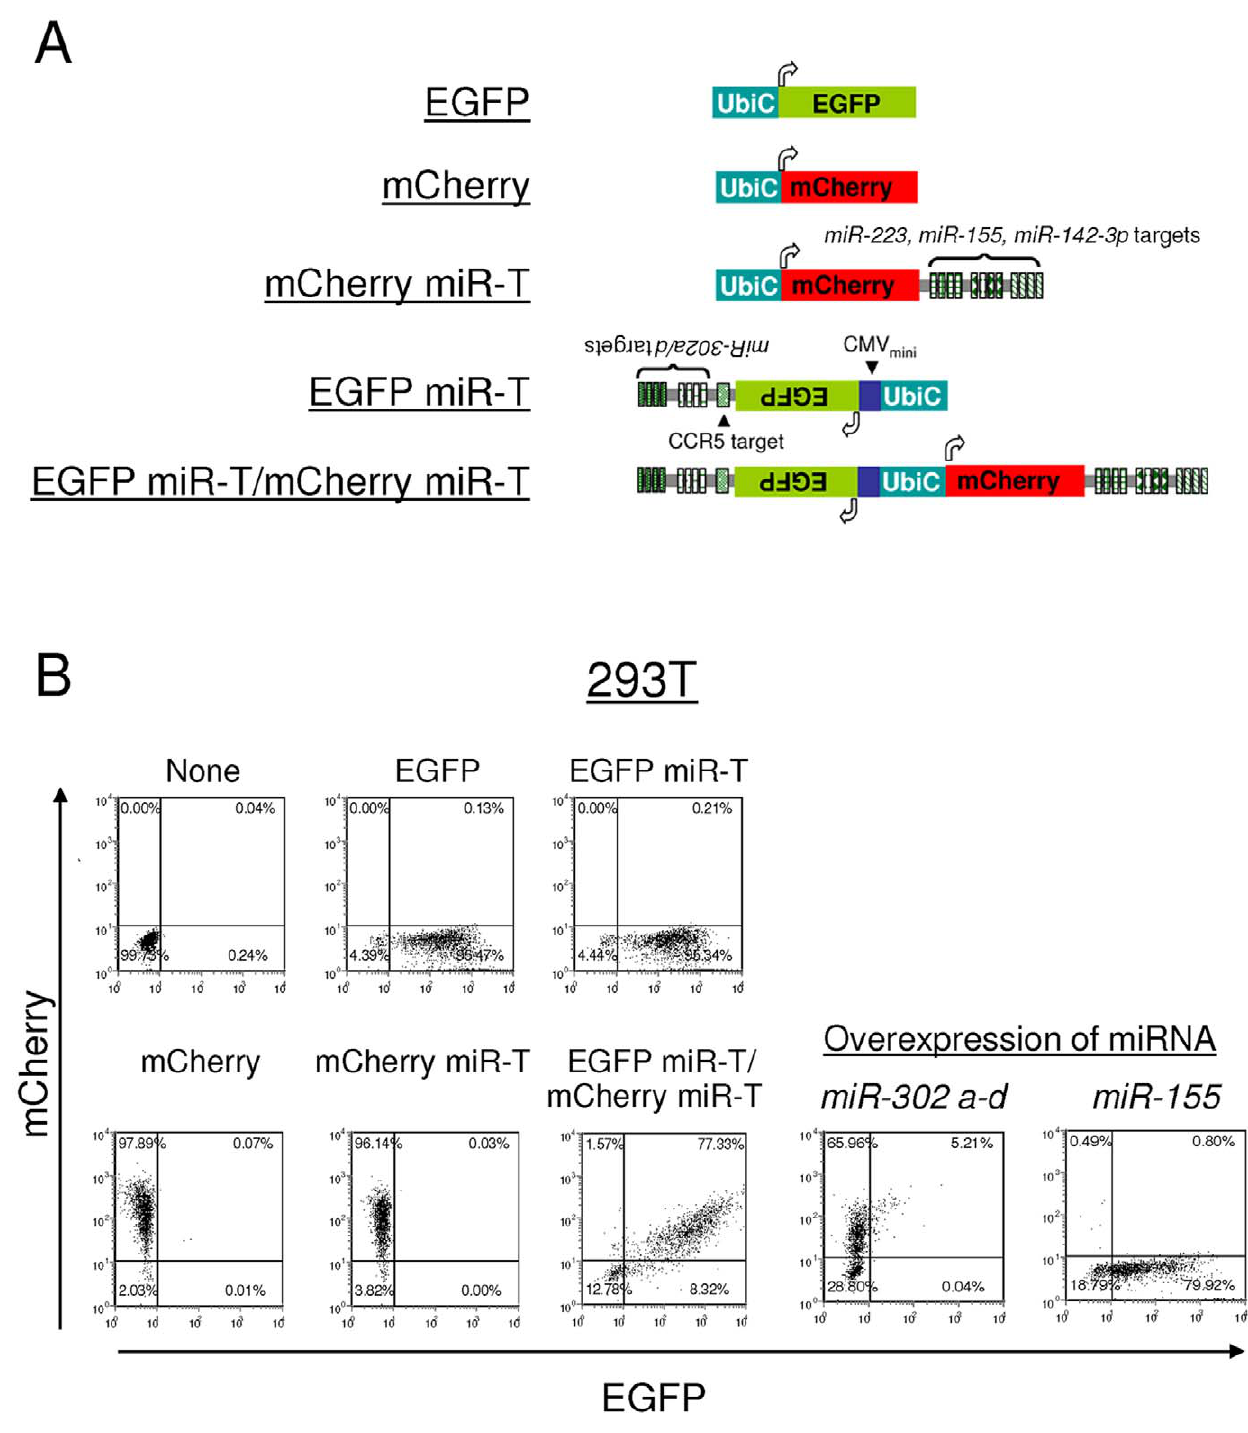
Figure 1. Ectopic expression of the miRNAs specifically suppresses expression of the reporter vector containing miRNA targets in 293T cells. (A) Map of transcriptional units of the reporter vector used in this study. CMVmini: CMV minimal promoter. UbiC: ubiquitin C promoter. CCR5 target: siRNA against CCR5 target sequence (5 9 -GAGCAAGCTCAGTTTACACC-3 9 ) [59]. (B) 293T cells were infected with lentiviral vectors encoding various reporters shown in (A). Expression levels of EGFP and mCherry were analyzed by flow cytometry 2 days post-infection. 293T cells infected with a lentiviral vector encoding EGFP miR-T/mCherry miR-T were super-infected by a lentiviral vector encoding either miR-302a , miR-302b , miR-302c , and miR-302d (miR-302 a-d) or miR-155 2 days post-infection. Cells were then further cultured for 4 days and analyzed for EGFP and mCherry expression by flow cytometry. The number (%) in each quadrant is listed on each plot.